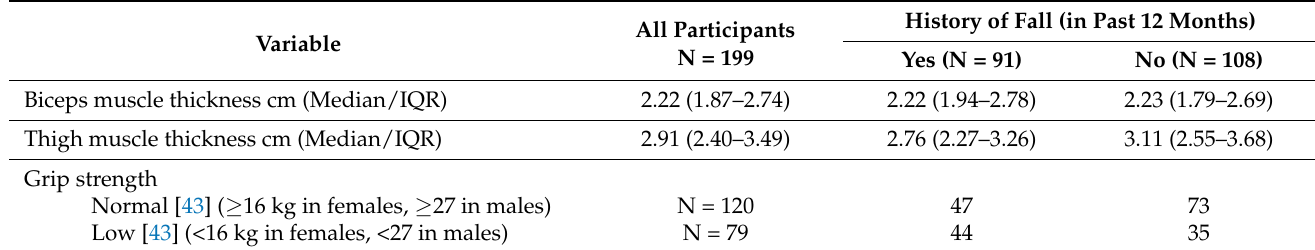
Table 2. Sonographically measured muscle thickness and grip strength among those who had